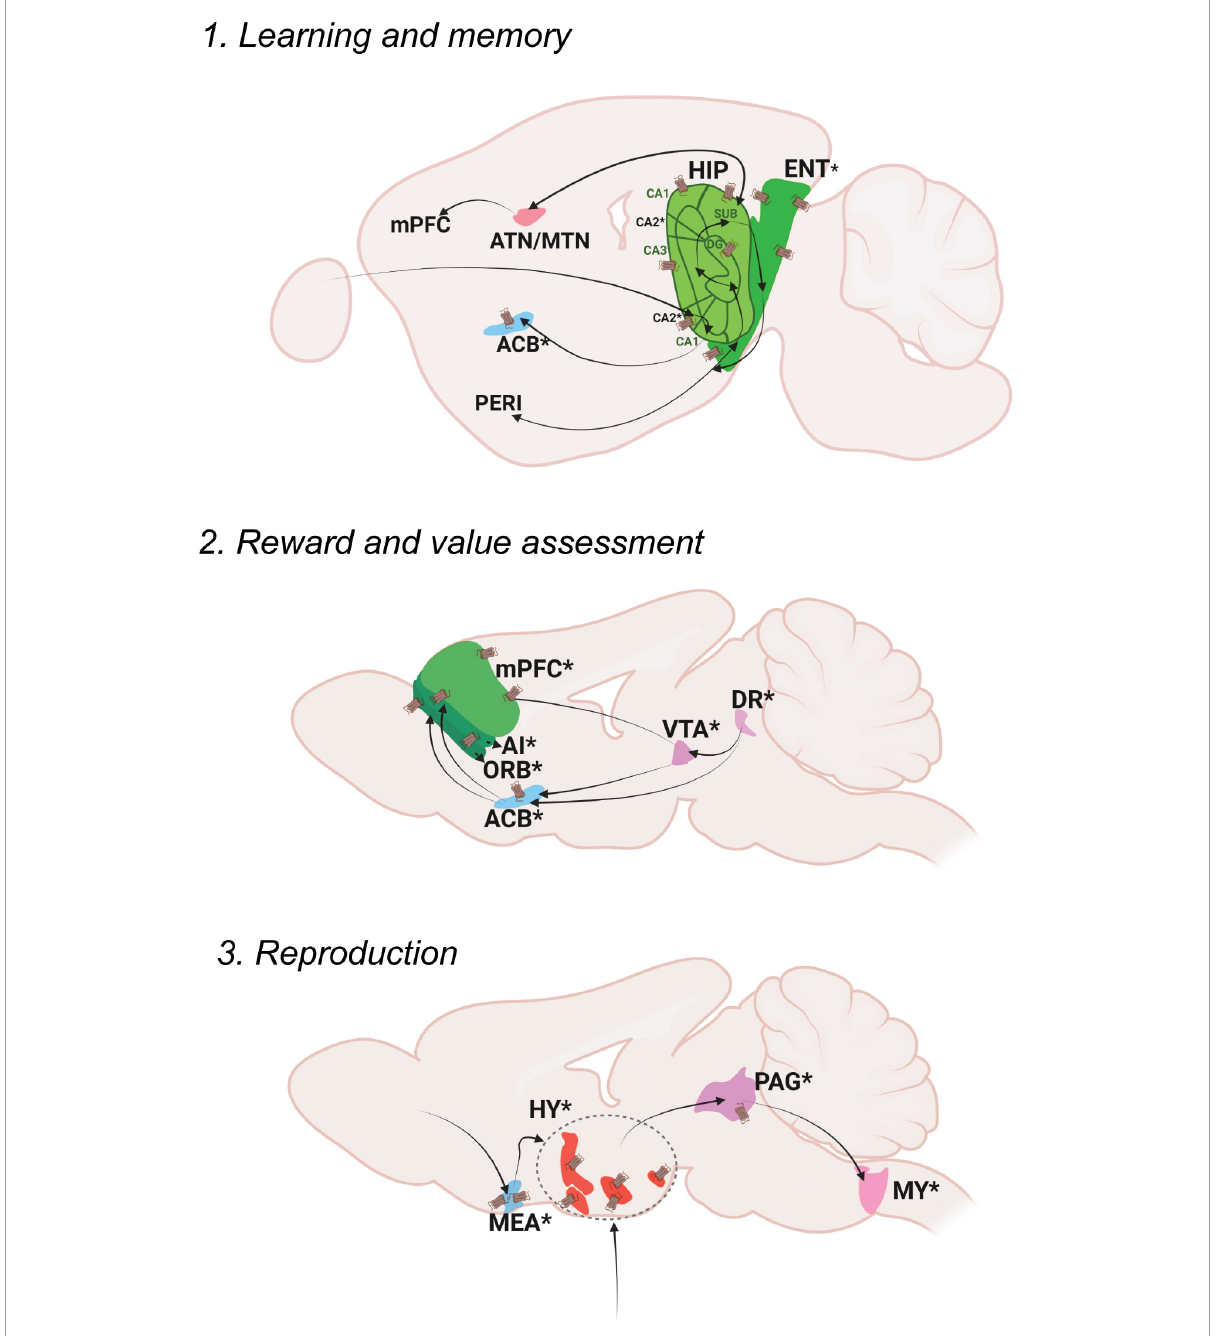
FIGURE3 Oxt regulation of Cognitive Control. Pathways depicting three different functional nodules: 1. Learning and memory, 2. Reward and value assessment, 3. Reproduction. For further details refer, Figure 1 legend. For abbreviations, refer Table 1 .